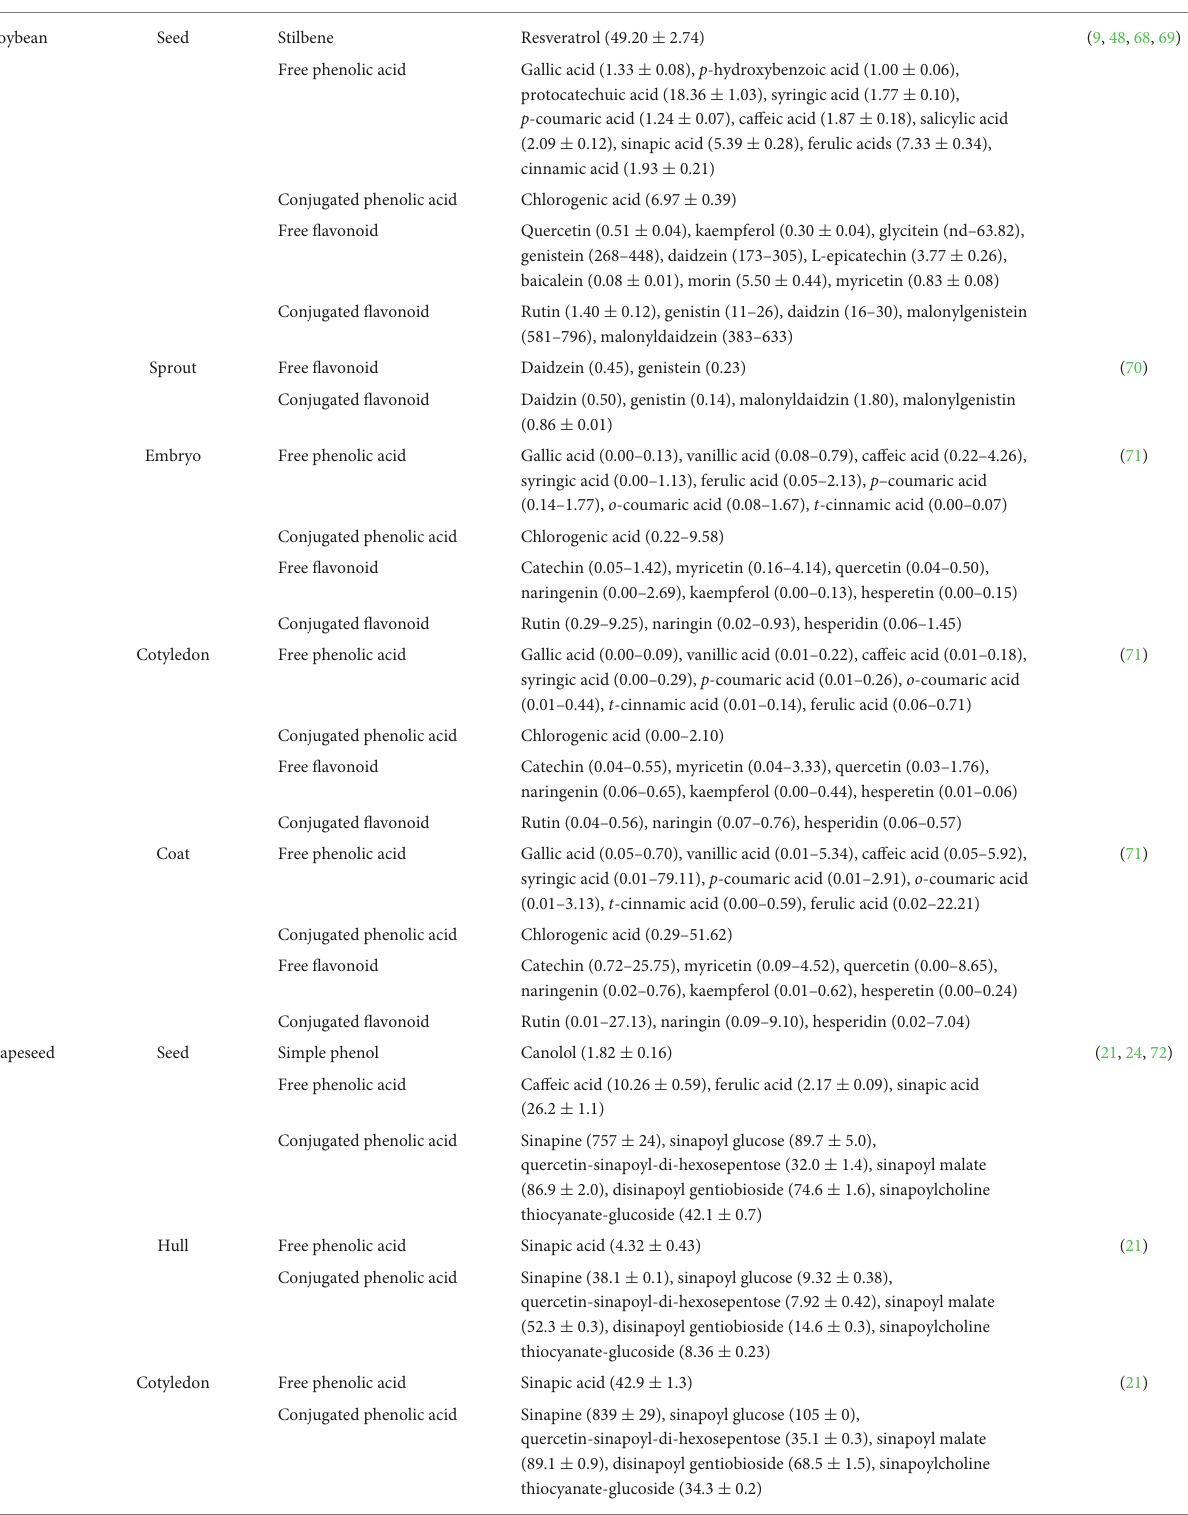
TABLE 1 Composition distribution of phenolic compounds in common oilseeds and their products.